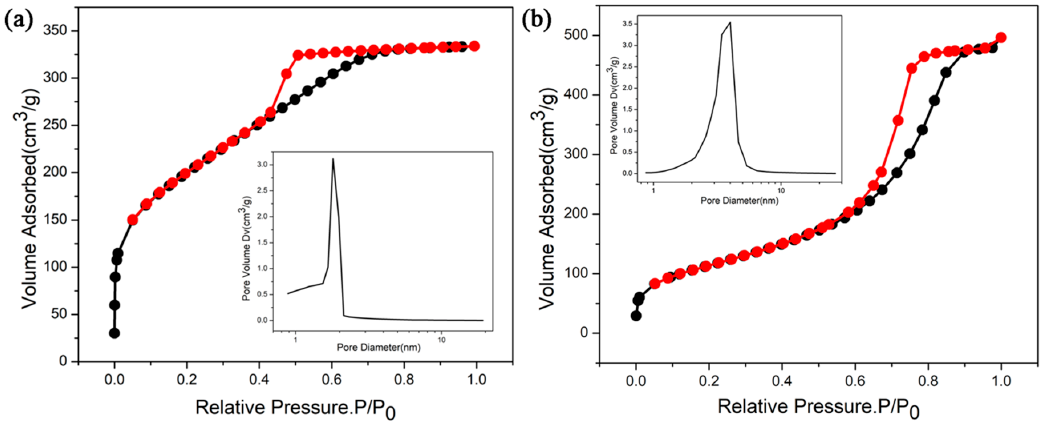
Figure 2. ( a , b ) The N 2 adsorption-desorption isotherms and the pore size distributions of silica aerogel and RLSA , respectively.